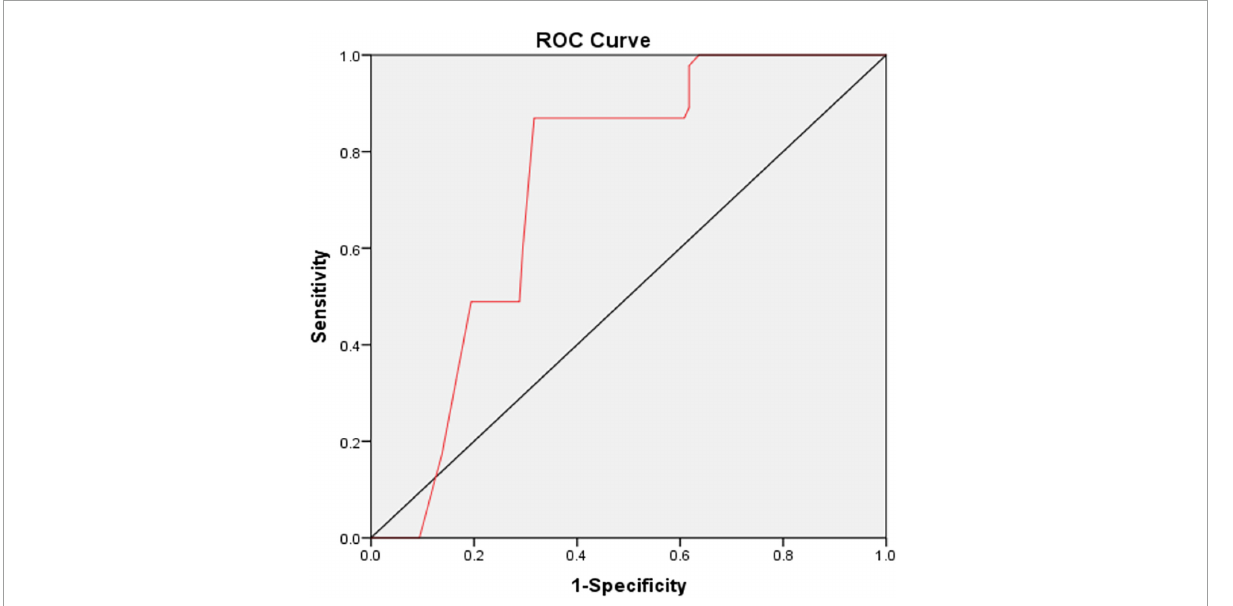
FIGURE2 The ROC curve analysis for MHR in predicting PSD. The cut-off value of MHR was 0.55, with a sensitivity of 87% and a specificity of 68.3%, AUC: 0.660 (95% CI: 0.683–0.781; P = 0.003). ROC, receiver operating characteristic; MHR, monocyte to high-density lipoprotein cholesterol ratio; PSD, post-stroke depression; AUC, area under the curve; CI, confidence